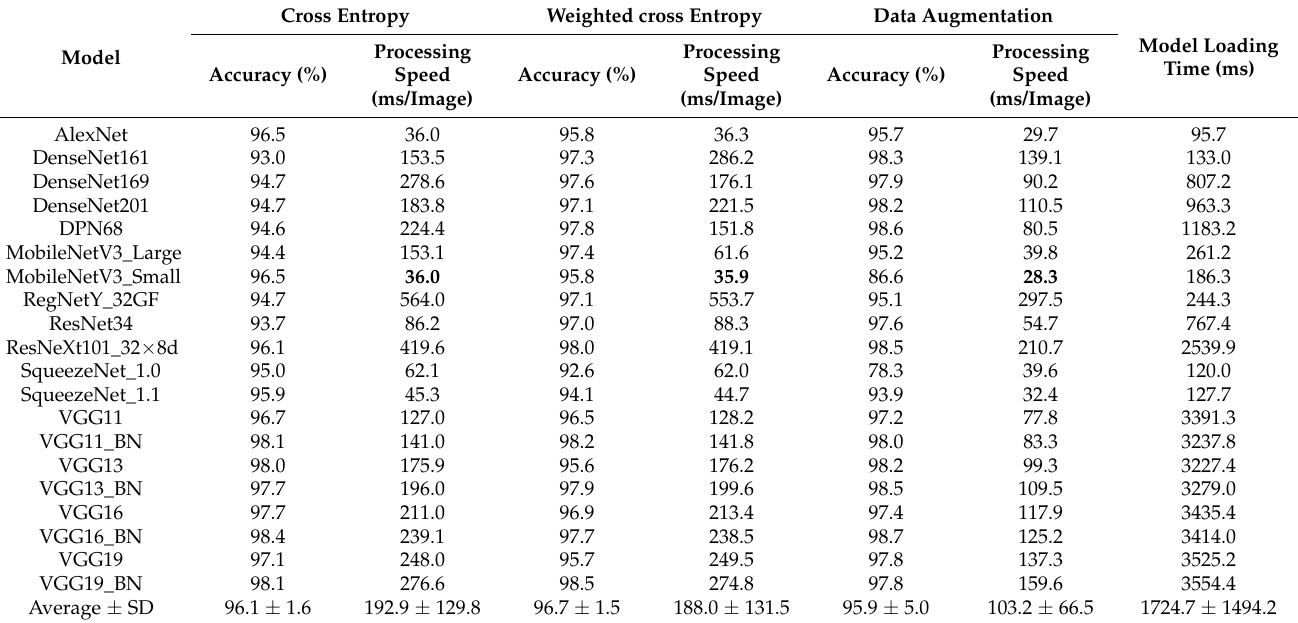
Table 5. Accuracy and processing speed for the 20 selected models before and after optimization for class imbalance. The outperformed models for each parameter were highlighted in bold